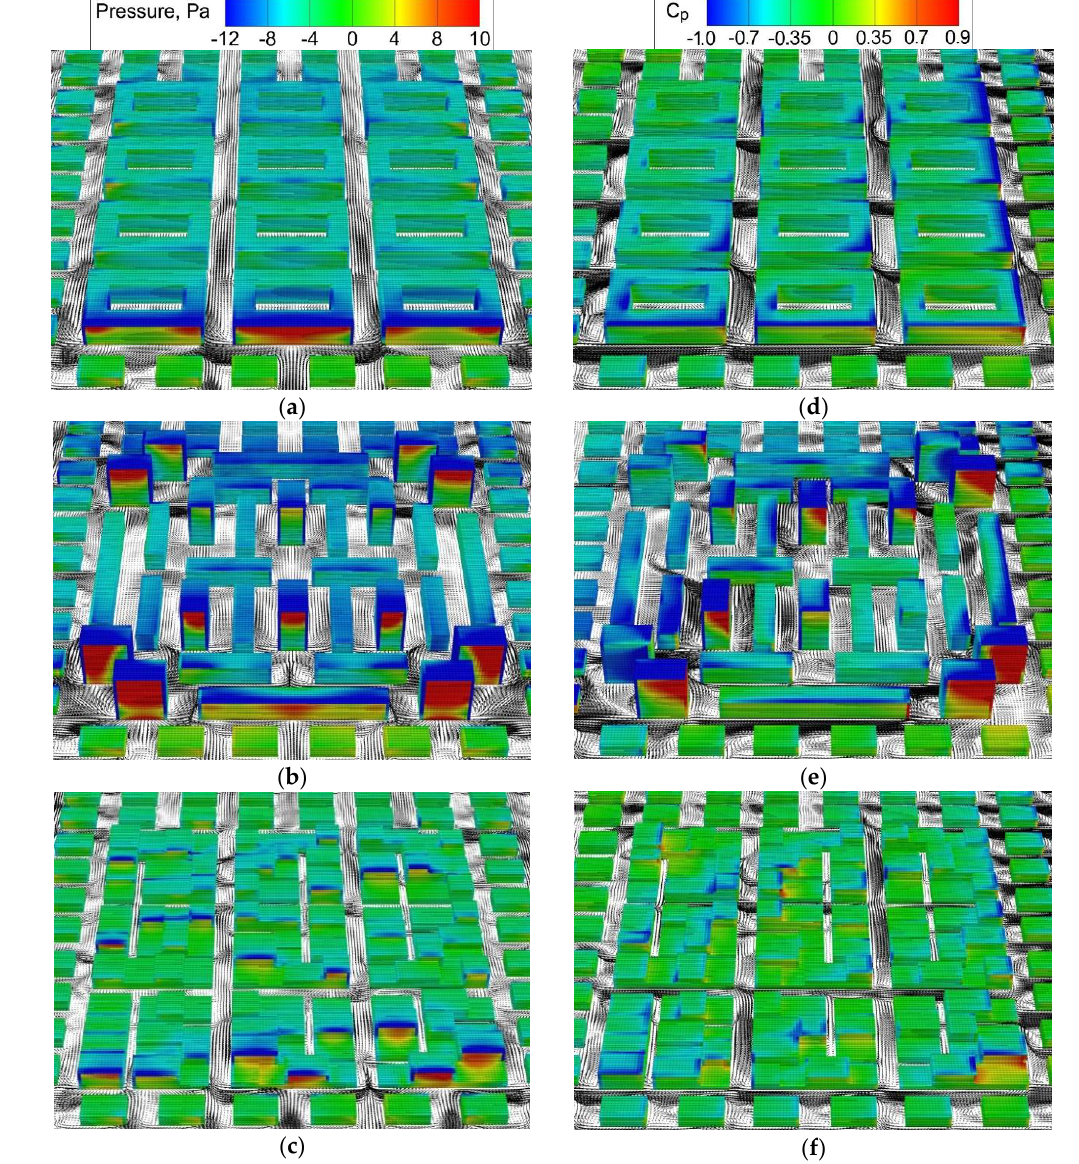
Figure 2. CFD prediction results of air pressure and wind pressure coefficient distribution on building surfaces and air speed vectors at the height of 2 m: ( a , d ) Urban morphology UM-1; ( b , e ) Urban morphology UM-2; ( c , f ) Urban morphology UM-3; ( a – c ) Perpendicular wind direction; ( d – f ) Sideward wind direction, 45°. Table 2. Results of air infiltration and expected impact on energy consumption calculations. Wind Urban Direction